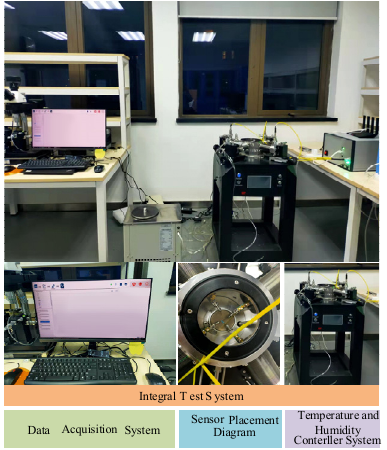
Figure 10. Diagram of the sensor test device.